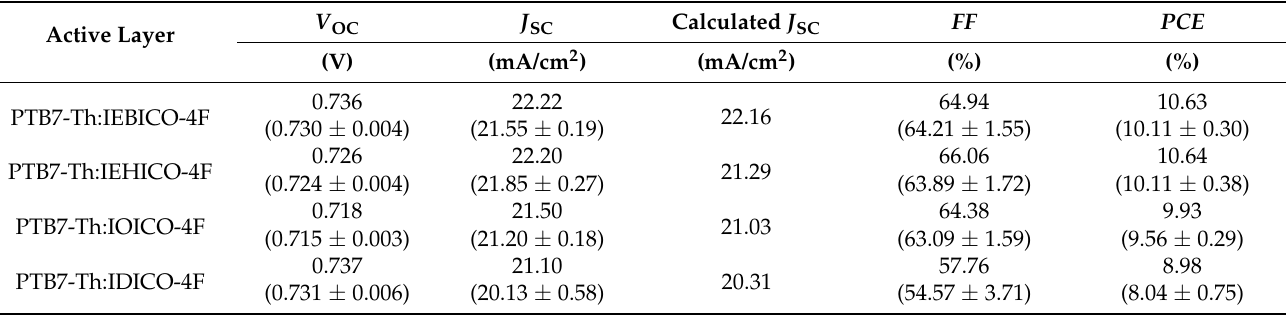
Figure 3. ( a ) J–V and ( b ) EQE curves of OSCs. Table 2. Device characteristics of the